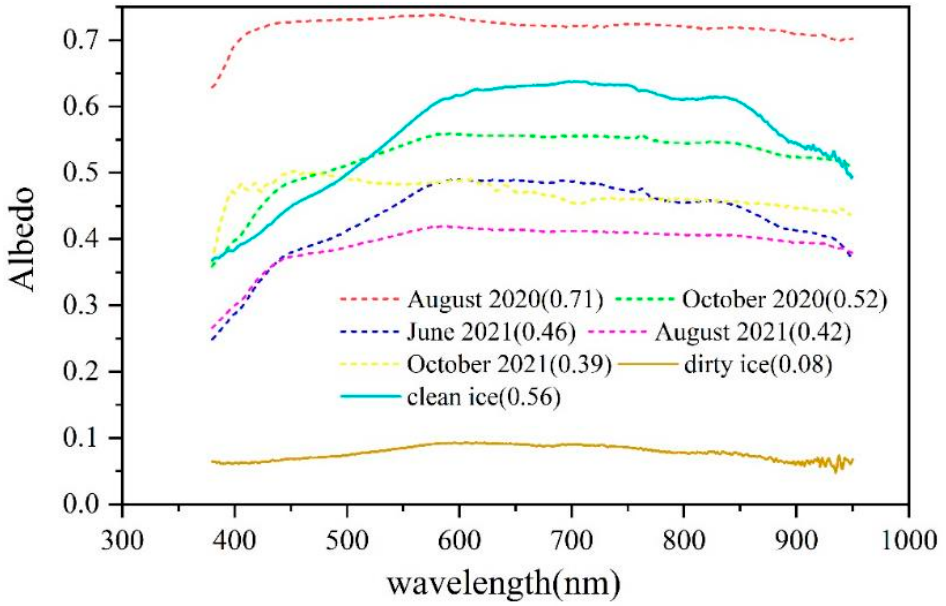
Figure 10. The albedo of the cover materials at different stages and that of the snow and ice surfaces. Albedo of clean snow and dirty ice is observed in August 2020 and August 2021. The average value is in parentheses in the legend.